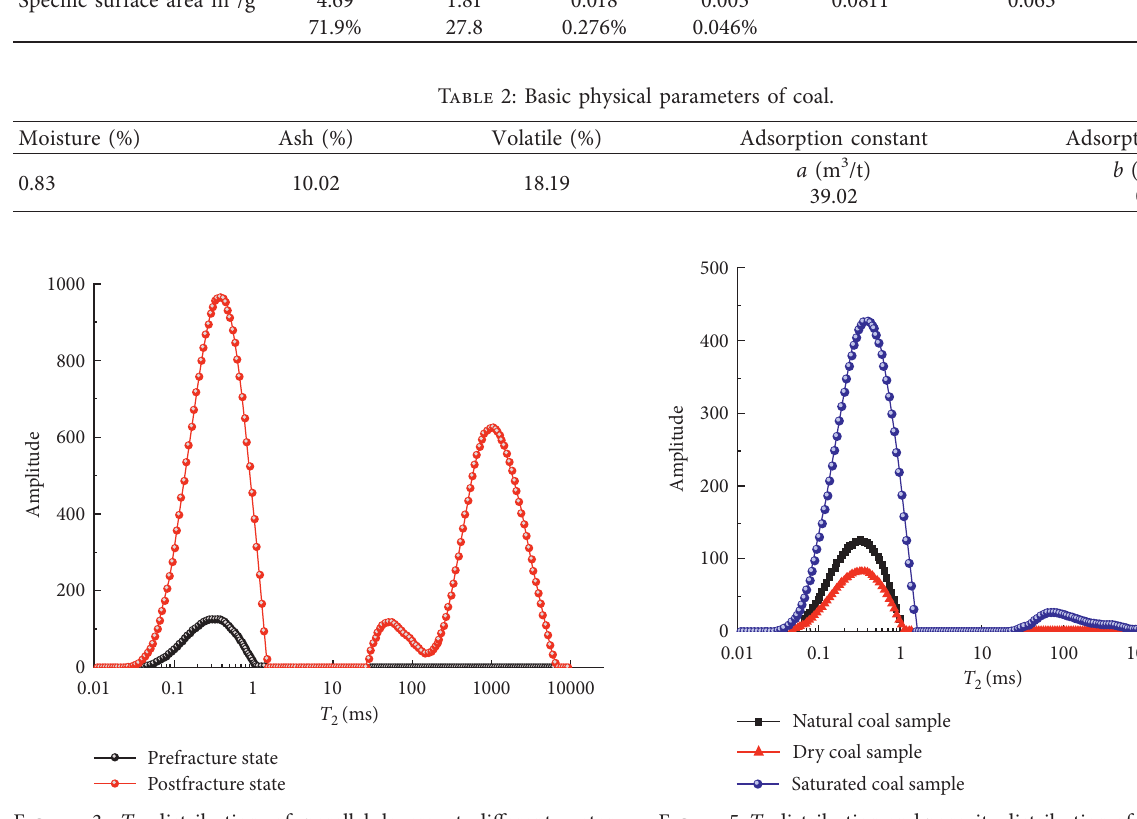
Figure 3: T 2 distribution of parallel layers at different water conditions of Yuwu, Shanxi.